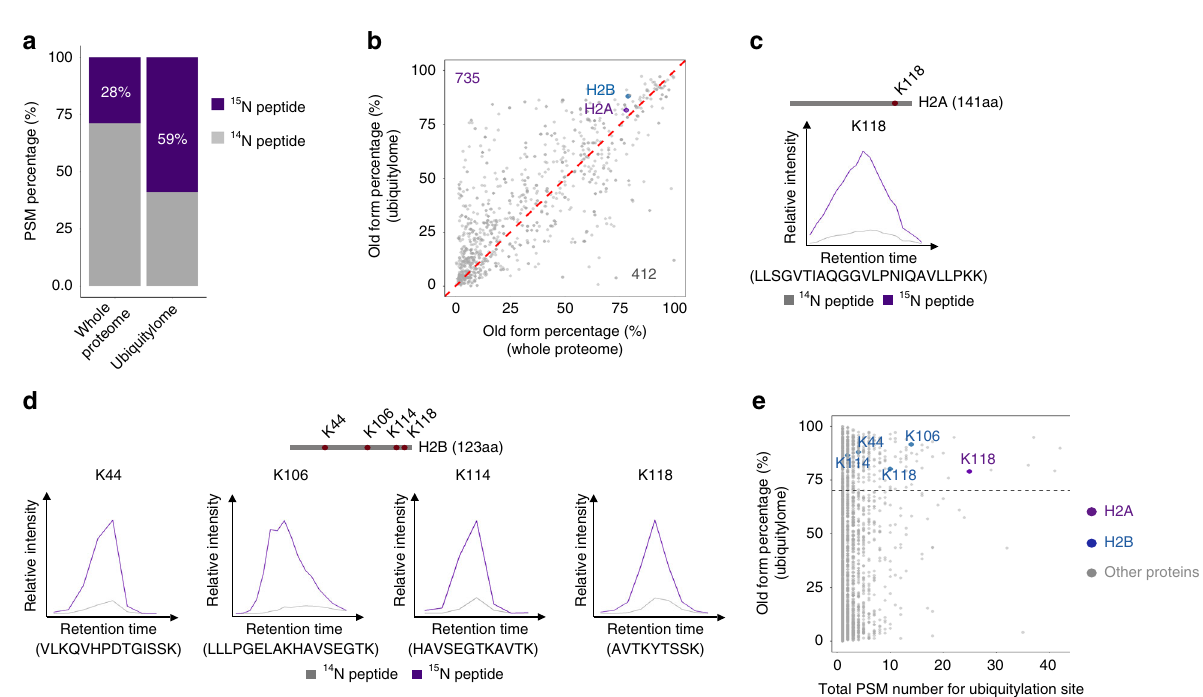
Fig. 1 Long-lived proteome analysis during Drosophila aging. a Experimental scheme of metabolic labeling in Drosophila . Flies were fi rst fully labeled with 15 N, and then switched to normal 14 N food at 5d. Samples were collected at 5d, 30d, and 60d of age. Proteomes of three tissues with indicated ages, and the ubiquitylome of 60d old head and muscle tissues were analyzed. The proportion of 15 N signal represents protein turnover rate. b 15 N proportions ( 15 N %) for each protein in different tissues and different aging time point. Proteins quanti fi ed during aging were compared across tissue types. A high 15 N % value at aging time point represents a slow turnover rate. The protein identi fi ers were used for comparison among multiple datasets in this study. c Clustering of proteins according to their 15 N proportion changes during aging. Proteins in cluster 1 were characterized with the slowest turnover rates thus de fi ned as extremely long-lived proteins (ELLPs). The median values are marked at the center. The boxes extend from the 25th to 75th percentiles. The upper or lower whiskers extend from the hinge to the largest or smallest value no further than 1.5 times the interquartile range (IQR). d Venn diagram and GO analysis of ELLPs in head and muscle. 149 ELLPs were found in both head and muscle, two post-mitotic tissues, and then subjected to functional analysis, with “ nucleosome assembly ” as the most signi fi cant hit ( p = 5.2e-9, Fisher ’ s exact test). e H2A and H2B are ELLPs. H2A and H2B belonging to “ nucleosome assembly ” category were identi fi ed with a dramatic enrichment of 15 N signals at day 60. The extracted ion chromatographs (XICs) of the paired 15 N and 14 N peaks from two representative peptides were compared